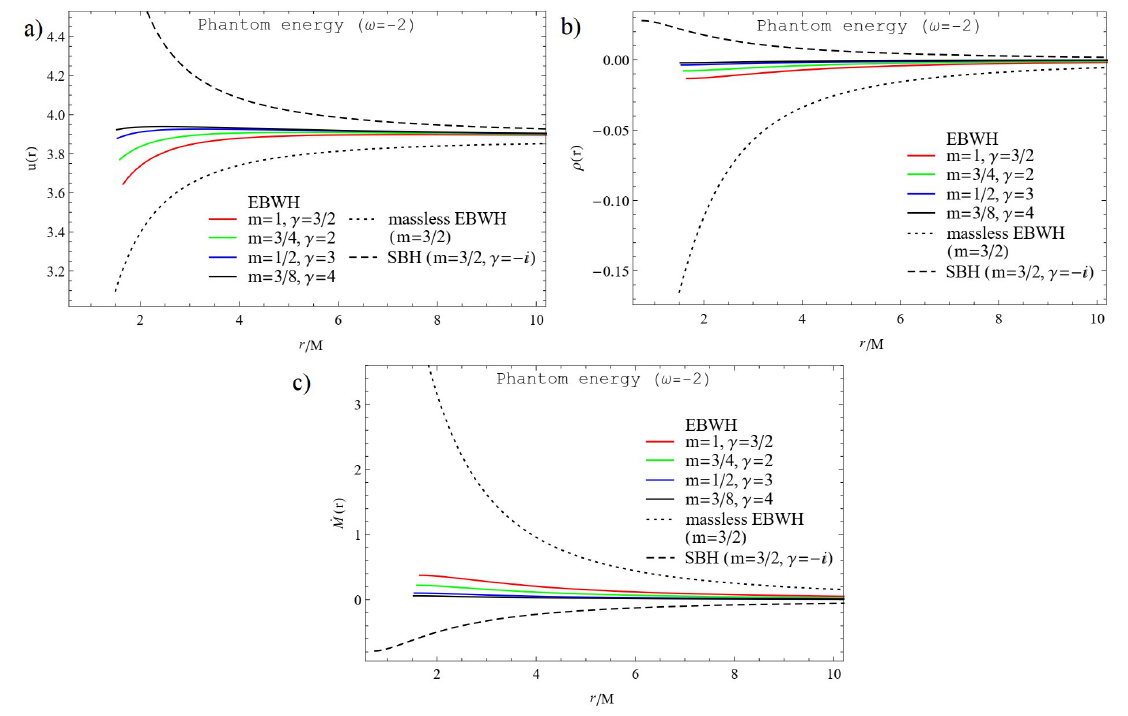
2) and rate of change of mass ( c ) of EBWH −